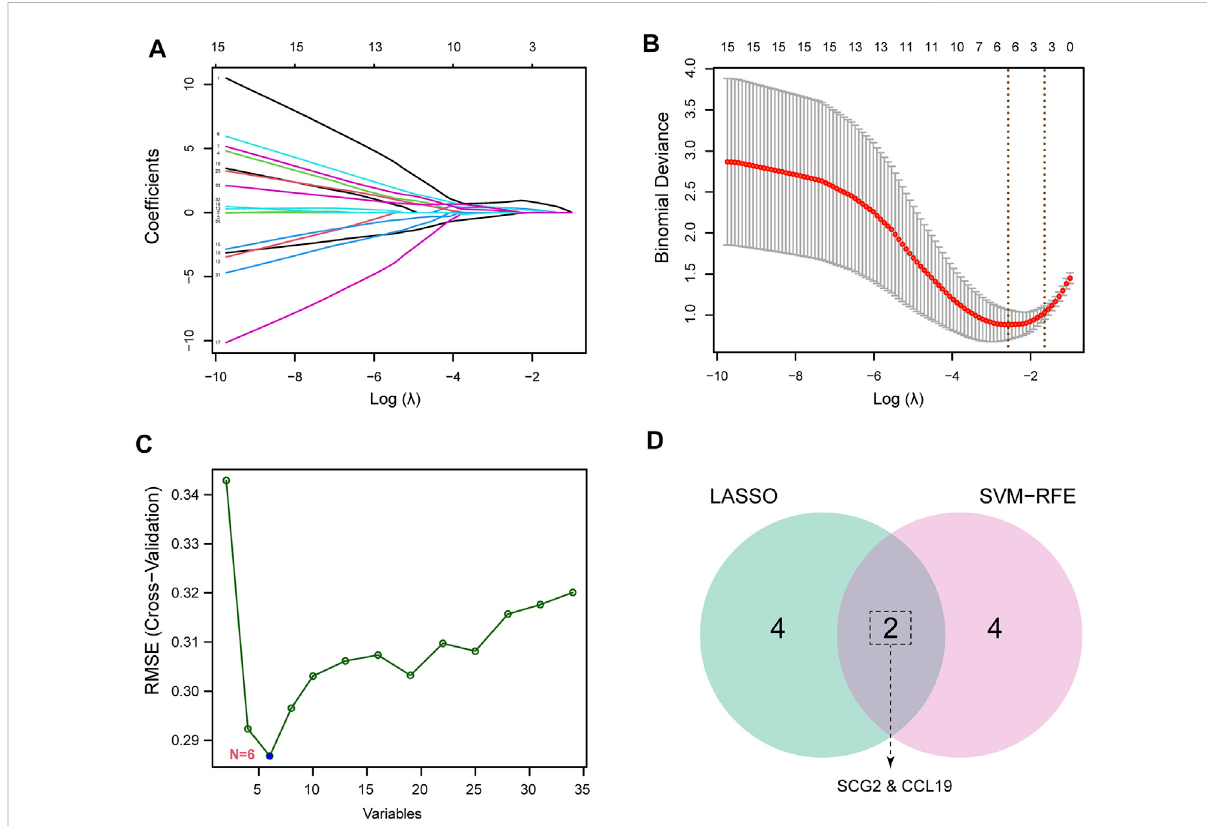
FIGURE 4 Screening for key feature genes by machine learning algorithms. (A,B) Feature genes identi fi ed using the least absolute shrinkageand selection operator (LASSO) logistic regression algorithm. Covariates are selected using the regularization parameter λ . (C) Support vector machine-recursive feature elimination (SVM-RFE) algorithm to screen feature genes. (D) Venn diagram demonstrating overlapping key feature genes screened by LASSO and